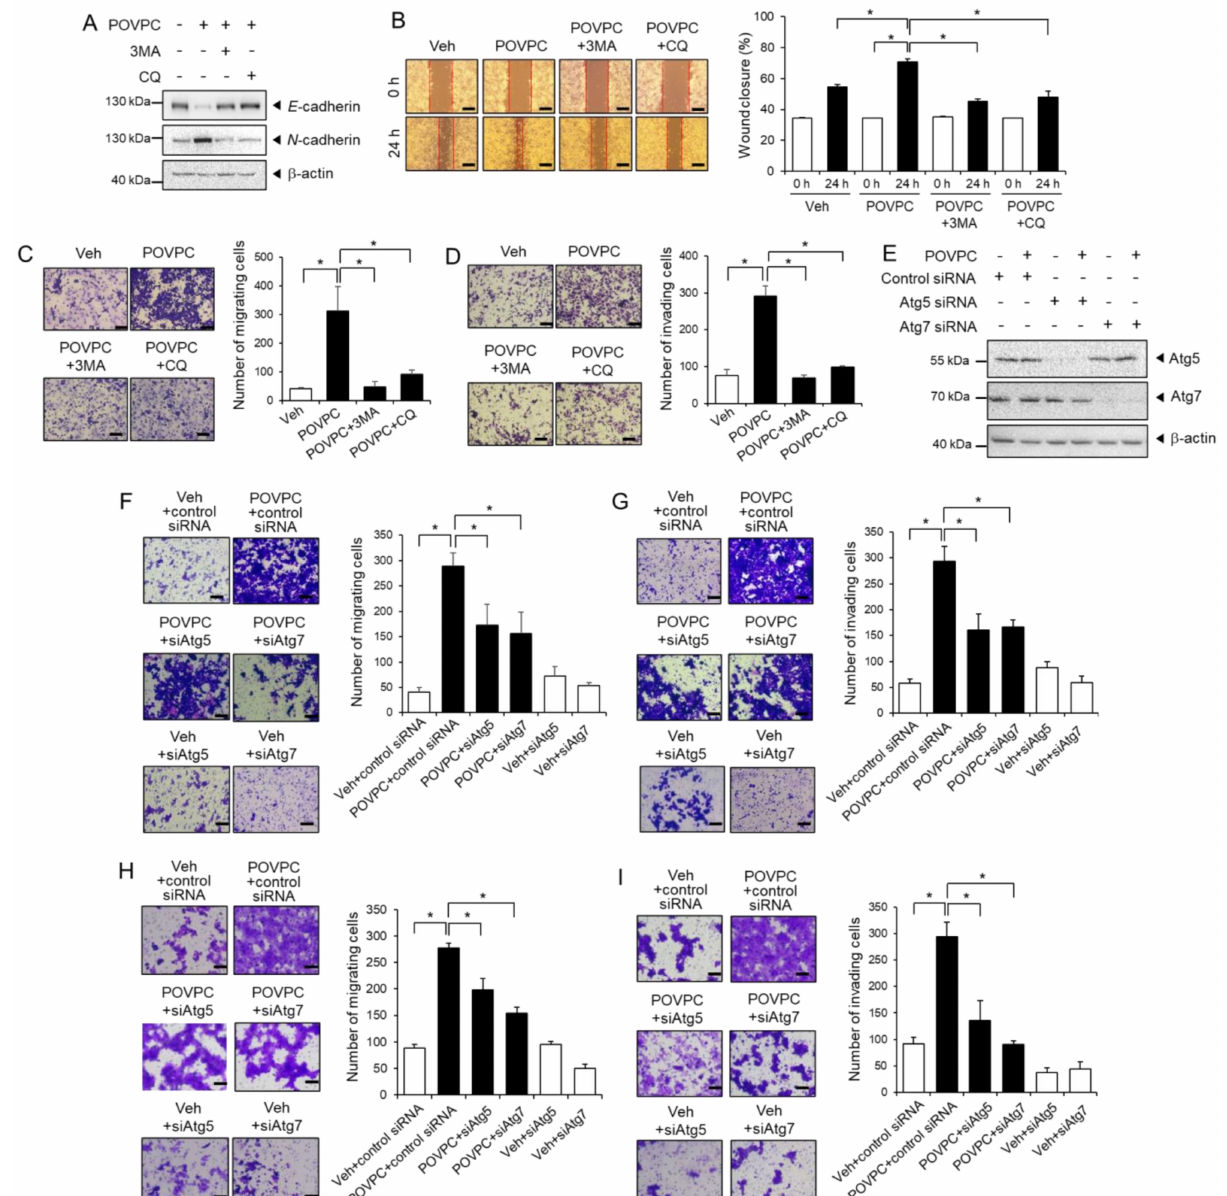
Figure 5. The pro-metastatic effects of POVPC are mediated through the autophagic pathway. ( A ) HepG2 cells were treated with POVPC (5 µ g/mL) in the presence or absence of autophagy inhibitors, 3MA (10 mM) or CQ (5 µ M), for 24 h. The levels of EMT-related protein markers were determined by immunoblotting with β -actin as the loading control. ( B ) HepG2 cells were wounded with a single scratch and treated with POVPC (5 µ g/mL) in the presence or absence of autophagy inhibitors, 3MA (10 mM) or CQ (5 µ M), for 24 h. Wound closure was determined using customized ImageJ software and the percentage of wound closure compared to unstimulated cells was calculated. ( C , D ) Migration or invasion of HepG2 cells was measured using a Transwell system after treatment with POVPC (5 µ g/mL) in the presence or absence of autophagy inhibitors, 3MA (10 mM) or CQ (5 µ M), for 24 h. ( E ) Knockdown of ATG5 and ATG7 expression in HepG2 cells using siRNA was determined by immunoblotting. ( F – I ) HepG2 cells (F, G) and MCF7 cells (H, I) were transfected with negative control siRNA, siRNA for ATG5, or siRNA for ATG7 and treated with POVPC (5 µ g/mL) for 24 h. Migration or invasion of HepG2 cells and MCF7 cells was measured using a Transwell system. The scale bar represents 100 µ m. For A and E, + means corresponding treatment and - means vehicle treatment. Values in the line graphs represent the mean ± SEM ( n = 3). *, p <